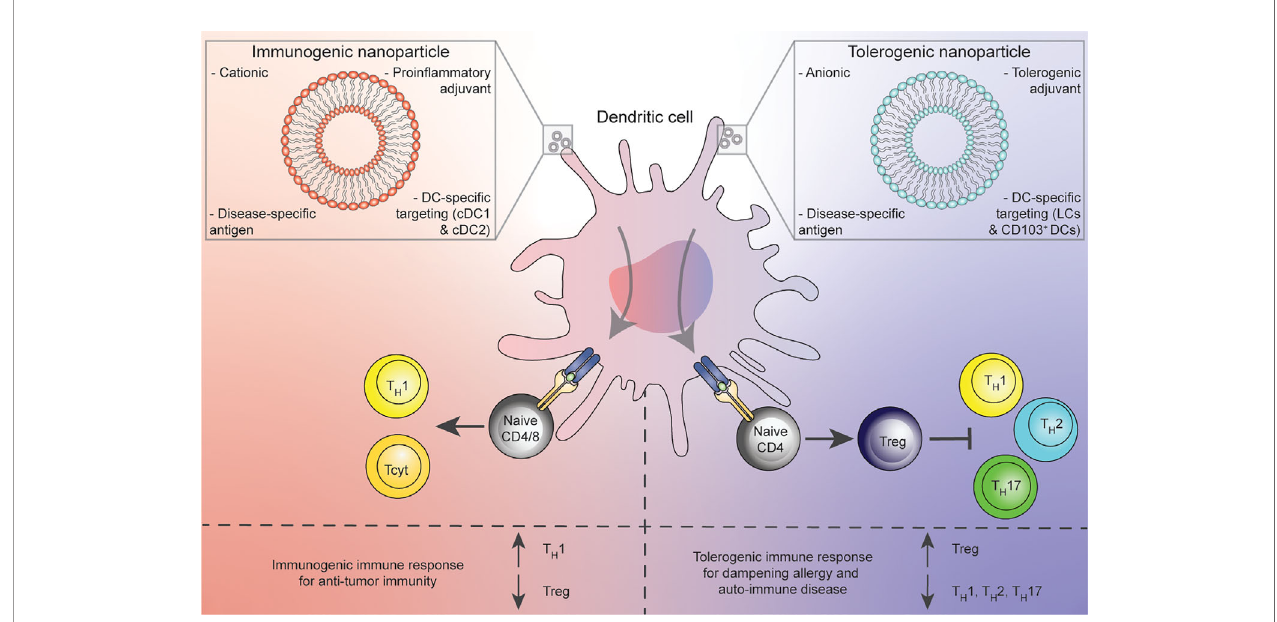
FIGURE 1 | Concept of in vivo treatment of DCs with immunogenic (red) or tolerogenic (blue) nanoparticle platforms resulting in pro-in fl ammatory DCs that prime for T H 1 or Tcyt polarization against cancer (left) or Tregs for the dampening of allergic and auto-immune conditions